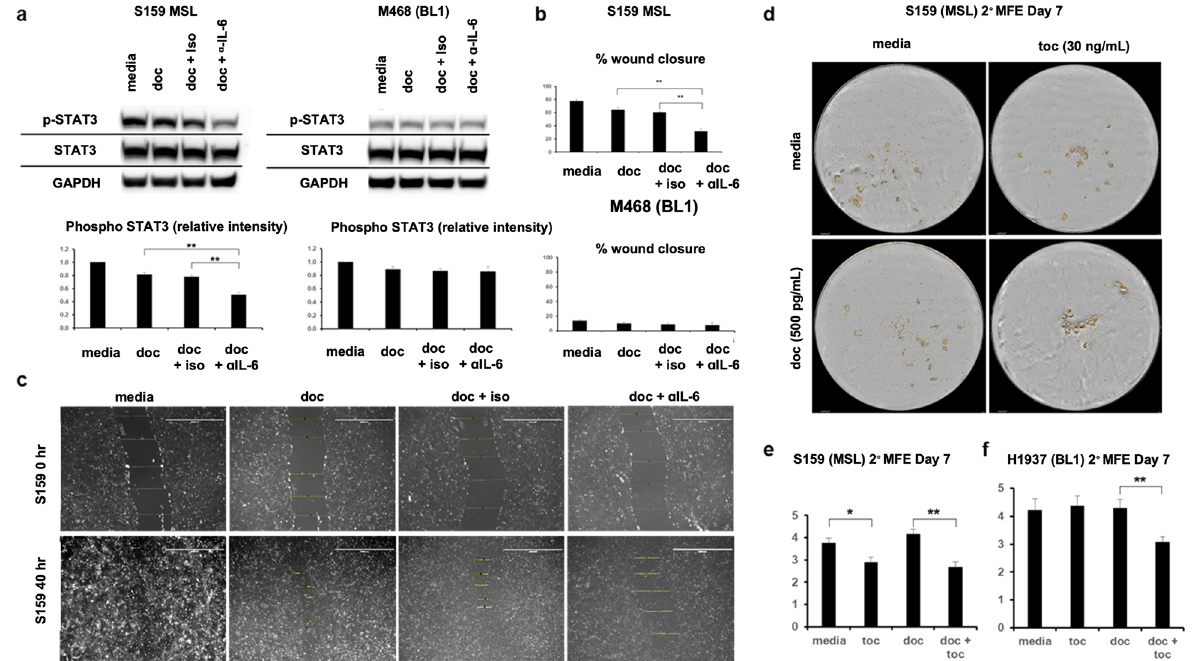
Fig. 4 IL-6 neutralization in combination with docetaxel provides bene fi t against MSL TNBCs, but not BL1 TNBCs. a The indicated TNBC cell lines were treated with docetaxel (4 ng/ml) with or without anti IL-6 neutralizing antibody (0.1 μ g/ml) or isotype control for 24 h, and then western blot was performed. Shown are representative western blot images and average ± SEM densitometry of phosphorylated STAT3 from n = 3 biological replicates for both TNBC cell lines. b Scratch migration for TNBCs treated for 40 – 48 h with or without docetaxel (4 ng/ml), anti IL-6 neutralizing antibody (1 μ g/ml) and isotype control (1 μ g/ml). Shown are average ± SEM % wound closure from n = 5 biological replicates for all cell lines. c Representative (from b ) scratch migration image for S159 at t = 0 h and t = 40 h. d Secondary mammospheres treated in the presence or absence of docetaxel (500 pg/ml) or tocilizumab (30 ng/ml). Mammospheres were counted on day 7 on Incucyte by threshold of cell area >1256 μ m 2 . Shown is a representative image from S159 (MSL) on day 7. e Shown are average ± SEM mammosphere formation ef fi ciency (MFE) from n = 8 biological replicates of S159 (MSL). f Shown are average ± SEM MFE from n = 8 biological replicates of BL1 TNBC. Statistical analysis performed with unpaired t -test: * p < 0.05; ** p < 0.01. All indicated experiments are representative of at least two independent